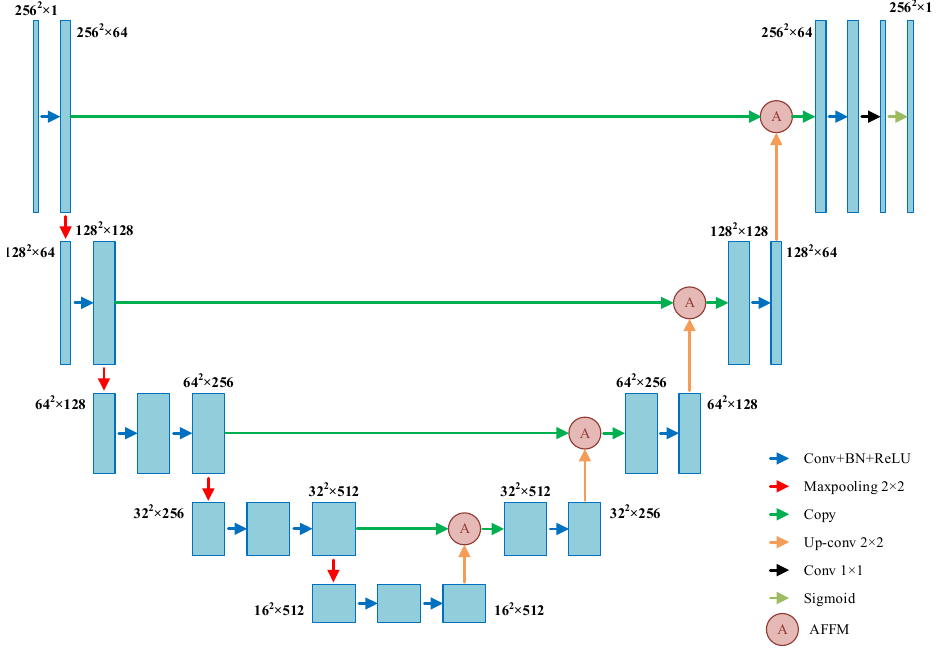
Figure 5. Improved U-net structure.